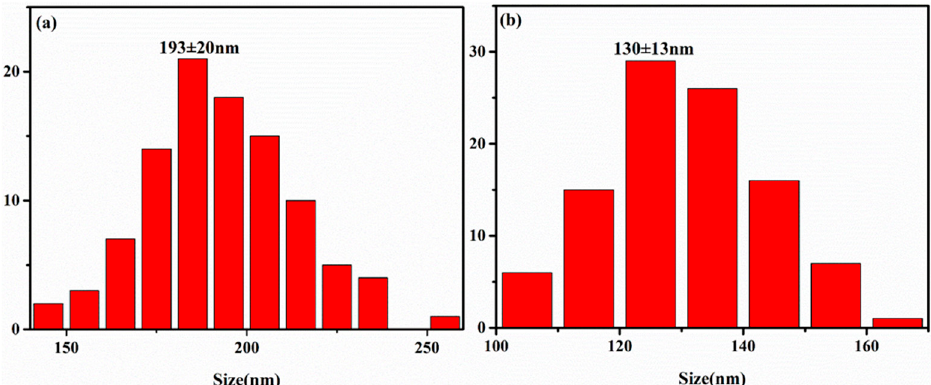
Figure 10. Particle size distribution of pristine PPTA-PDA/Ag fibers ( a ) and plasma-treated PPTA-PDA/Ag fibers ( b ).